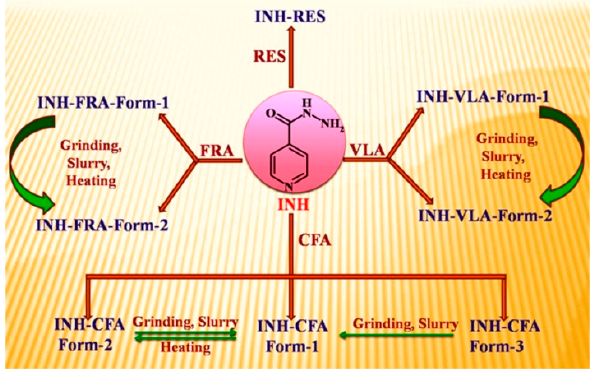
Figure 46. Various cocrystals of isoniazid prepared using nutraceuticals as coformer. Adapted with permission from Crystal Growth & Design , 2014, 14, 5991–6005. Copyright 2014, American Chemical